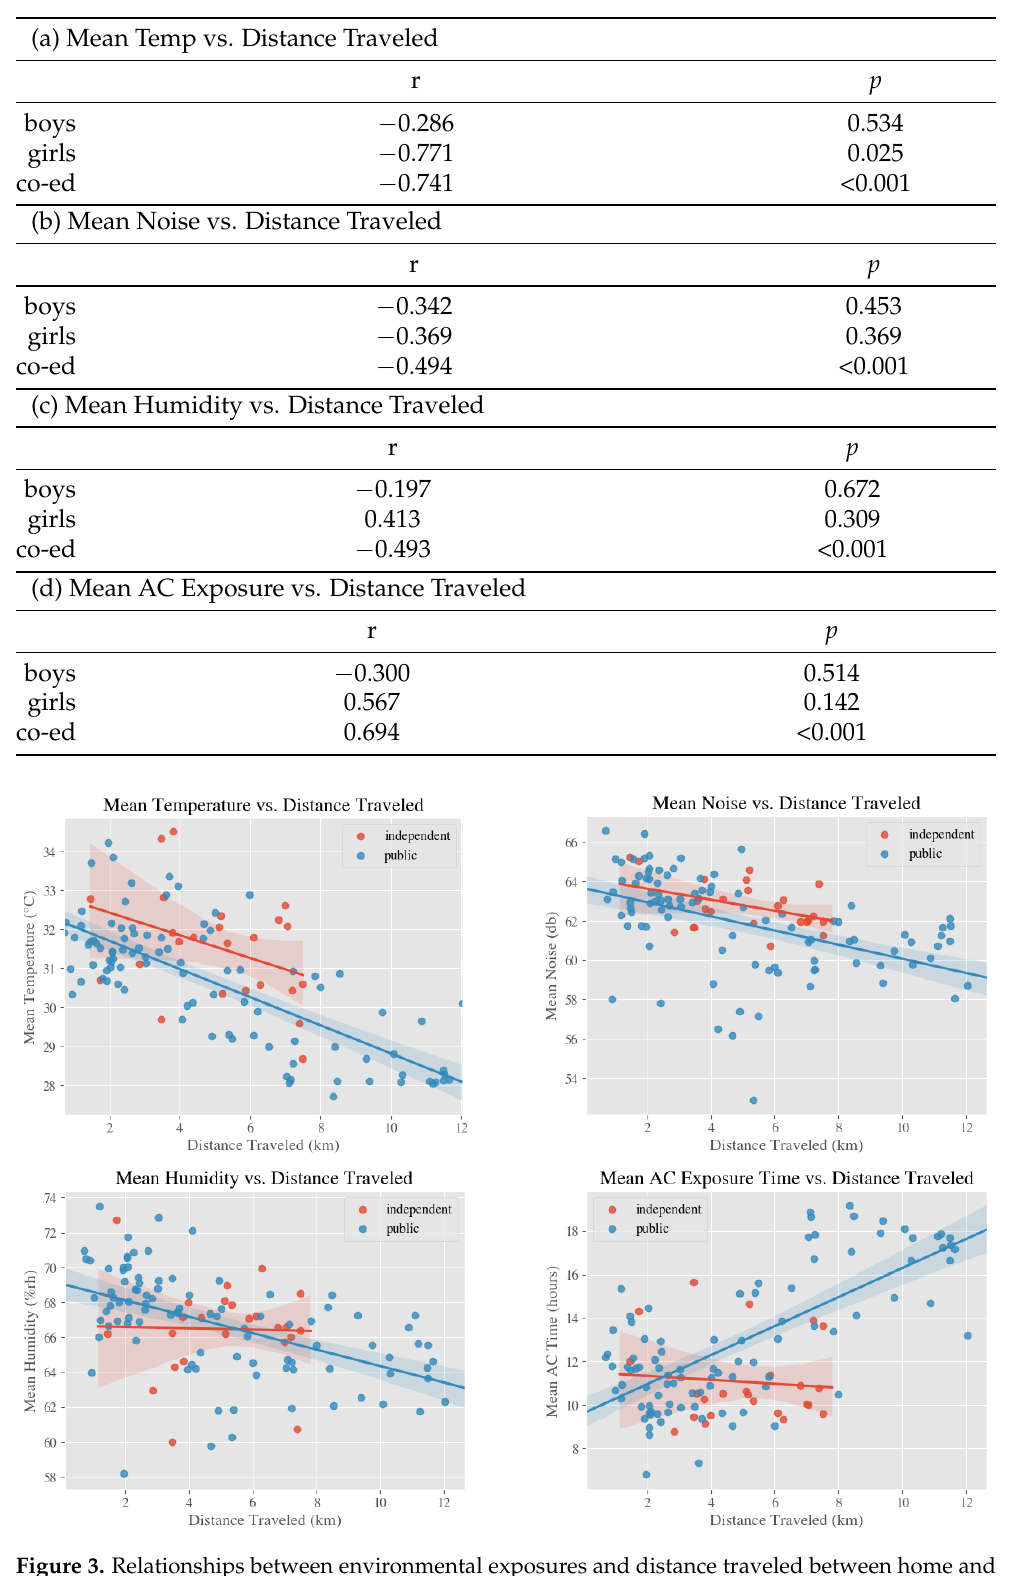
Table 1. Correlation between environmental exposures and distance to school with respect to gender.